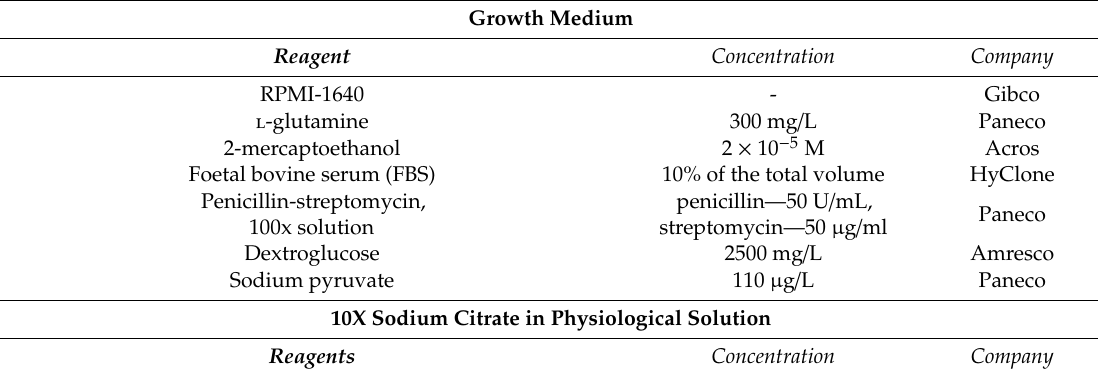
Table 1. Solutions and